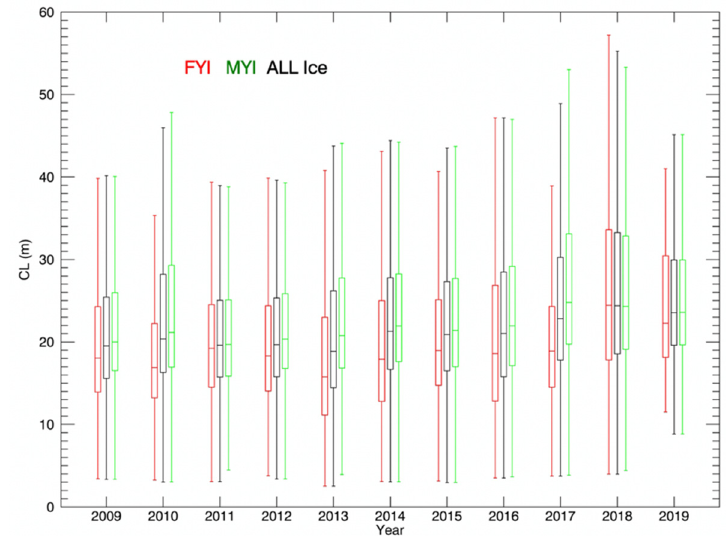
Figure 10. The box-whisker plot of correlation length (CL) of FYI (red), MYI (green), and all ice (black) from 2009 to 2019. The medians of CL show a trend of increase for all FYI, MYI, and all ice. Table 1. The mean and standard deviation of correlation length (CL) of FYI, MYI, and all ice. Year